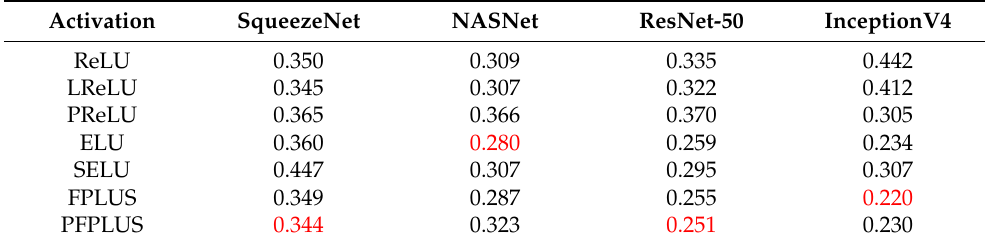
Entries in red color indicate the best results for each network under validation